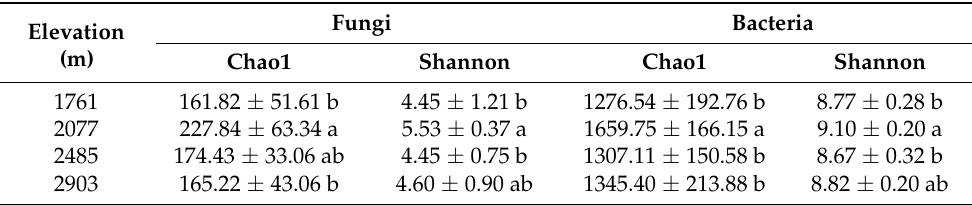
Table 2. Diversity of soil fungi and bacteria along the elevation gradient. Values are the mean ± SD; different lowercase letters a and b within the same row indicate significant differences ( p < 0.05).